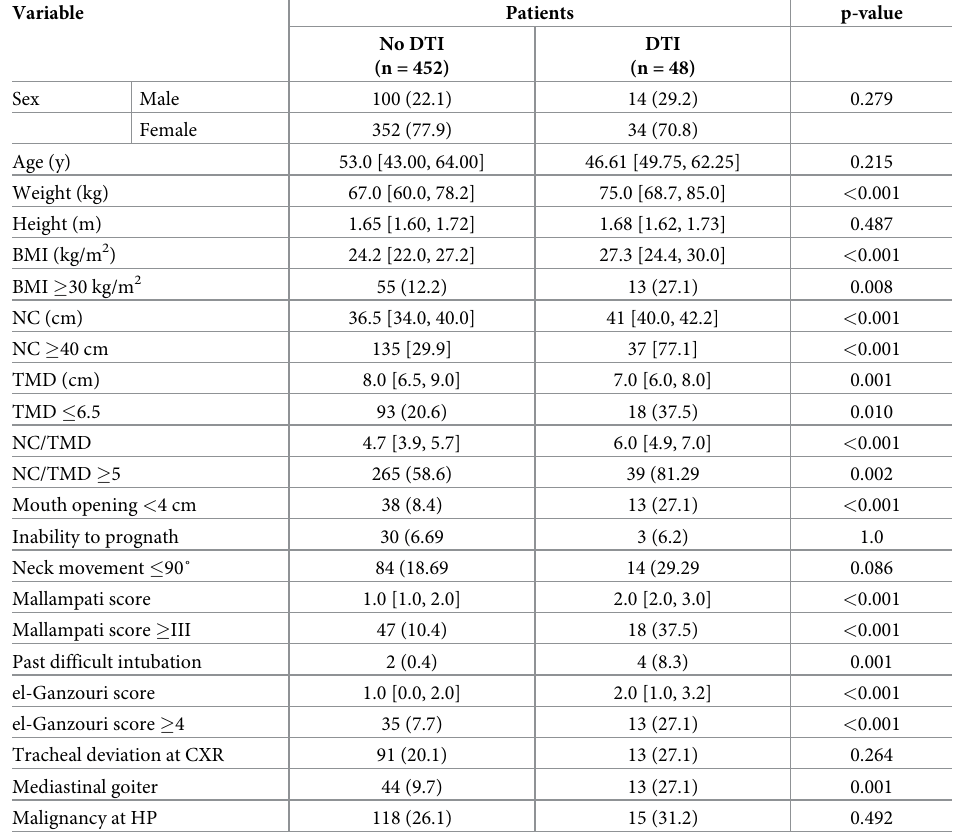
Table 1. Characteristics